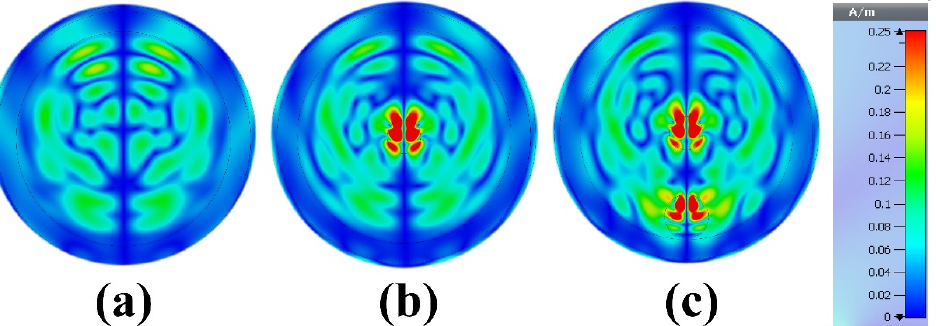
Figure 18. Reconstructed images of the breast phantom (H-field microwave imaging results): ( a ) phantom without tumor, ( b ) phantom with one tumor and ( c ) phantom with two tumors at 8.6 GHz.